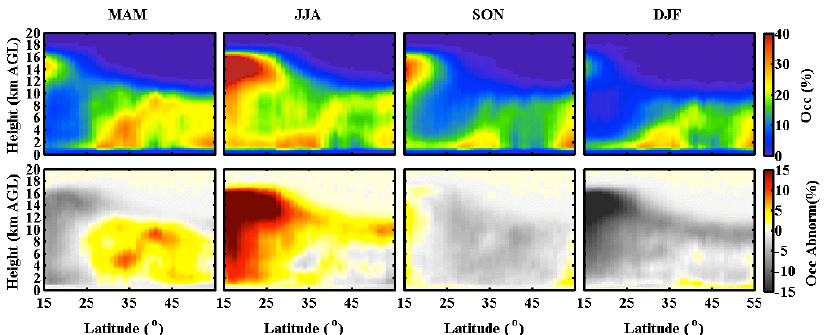
Figure 4. Seasonal variations (upper panel) and anomalies (lower panel) of zonally averaged vertical distributions of cloud occurrences over East Asia from the CloudSat 2B-CLDCLASS-LIDAR product.